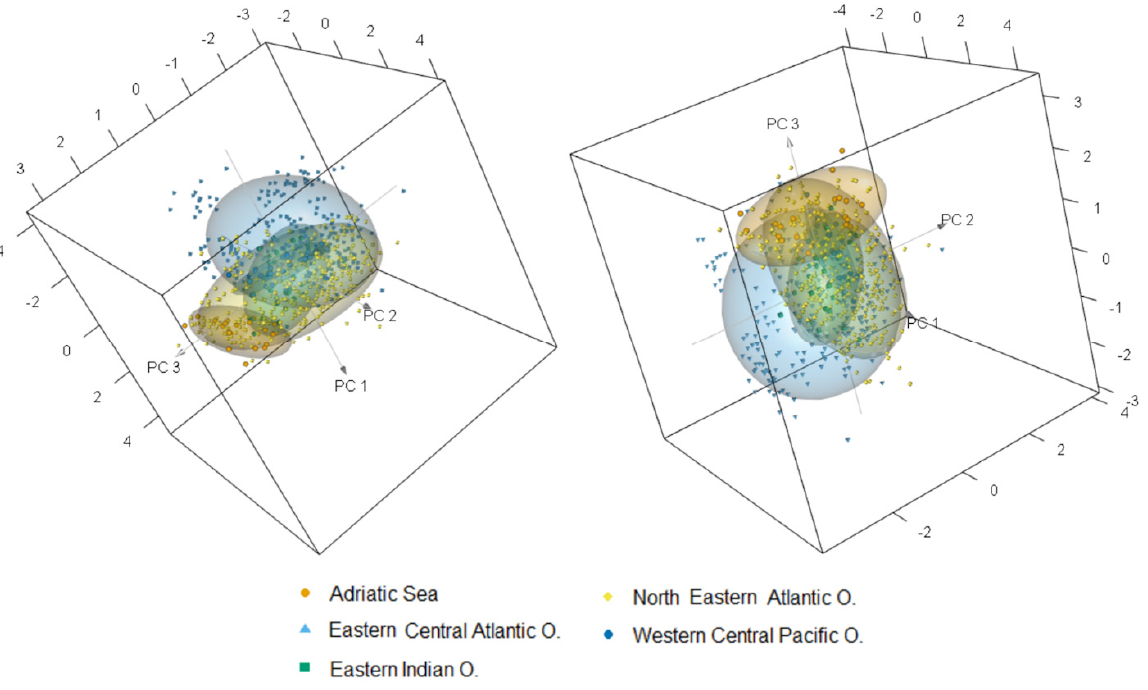
Figure 2. Principal component score plot for PC1, PC2, and PC3 of cuttlefishes originating from five FAO fishing areas. Ellipses represent the 75% confidence interval.